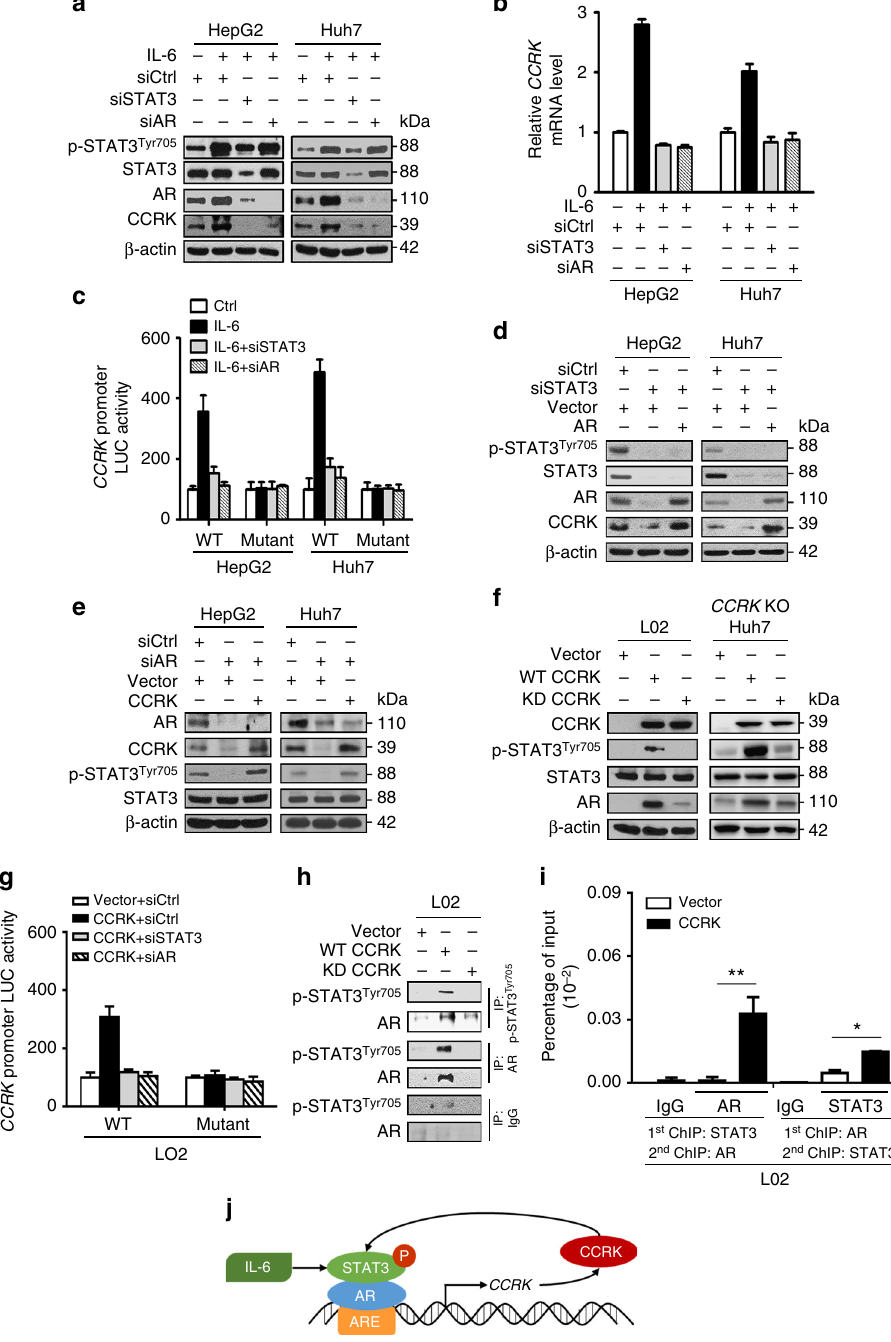
Fig. 3 IL-6 activates STAT3 and AR signaling to stimulate CCRK expression. a Western blot and b qRT-PCR analysis of HepG2 and Huh7 cells treated with or without IL-6, combined with siRNA-mediated knockdown of STAT3 or AR . c Luciferase reporter assay was used to measure CCRK promotor activity in HepG2 and Huh7 cells expressing either WT or AR response element (ARE)-deleted mutant CCRK promoter, treated with or without IL-6, combined with siRNA-mediated knockdown of STAT3 or AR . d CCRK expression was blocked by knockdown of STAT3 , but rescued by over-expression of AR. e STAT3 phosphorylation suppressed by AR knockdown could be rescued by over-expression of CCRK. f WT but not kinase-defective (KD) CCRK-induced STAT3 phosphorylation and AR expression. g CCRK induces its own promoter activity, which was abolished by deletion of ARE or knockdown of either STAT3 or AR in CCRK-expressing cells. h Co-immunoprecipitation of p-STAT3 Tyr705 and AR in LO2 cells transfected with WT CCRK, but not in those transfected with empty vector or KD CCRK. IgG is a control for non-speci fi c immunoprecipitation. i ChIP-re-ChIP assay demonstrated an increased co-occupancy of STAT3 and AR at the ARE of CCRK promotor in LO2 cells transfected with WT CCRK relative to those transfected with vector only. IgG is a control for non- speci fi c immunoprecipitation. The antibodies used in the 1st and 2nd ChIP are as indicated. j Schematic representation of the IL-6/STAT3/AR/CCRK circuitry in hepatocarcinogenesis. Data are presented as mean ± SD. * p < 0.05 and ** p < 0.01 as calculated by one-way ANOVA followed by